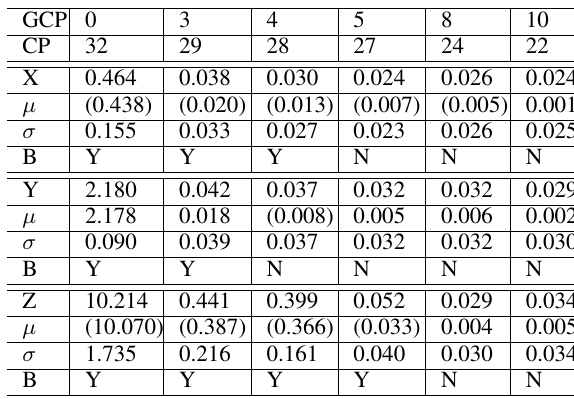
Table 1. Statistics of photo-triangulation with self-calibration GCP 0